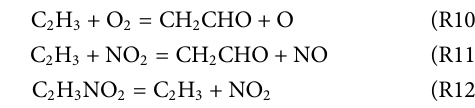
Frontiers in Energy Research |